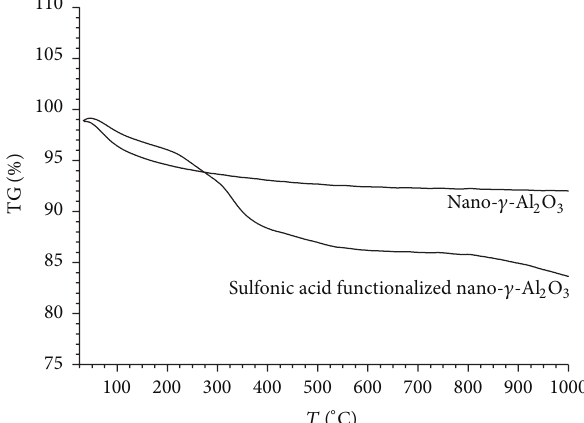
Figure 3: TG analysis of nano- 𝛾 -Al 2 O 3 (up) and sulfonic acid functionalized nano- 𝛾 -Al 2 O 3 (down).